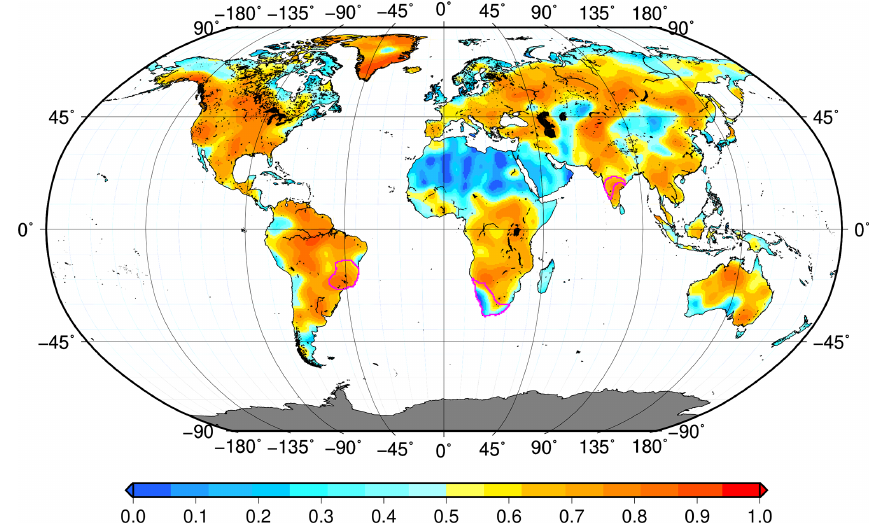
Figure 3. AR(1) model coefficients (–) for global GRACE-TWSC. The polygons of the clusters of eastern Brazil, southern Africa, and western India are added in